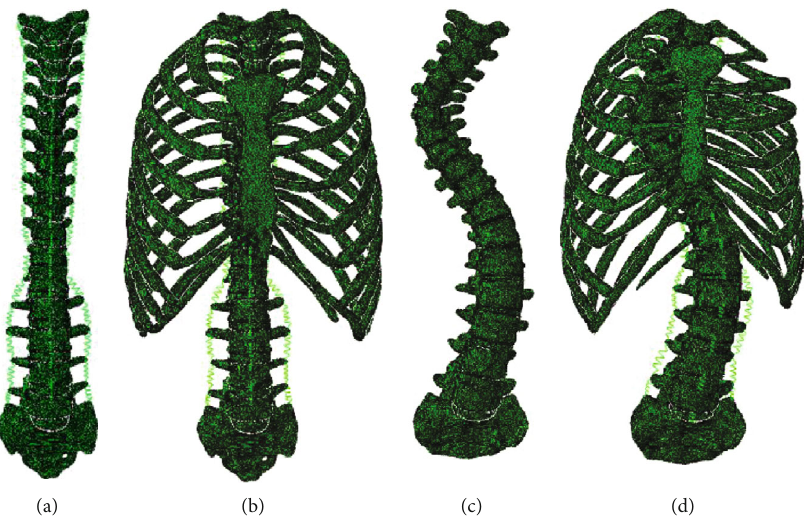
Figure 1: Four fi nite element models are shown: (a) normal spine without rib cage (NS1); (b) normal spine with normal rib cage (NS2); (c) scoliotic spine without rib cage (SS1); (d) scoliotic spine with deformed rib cage